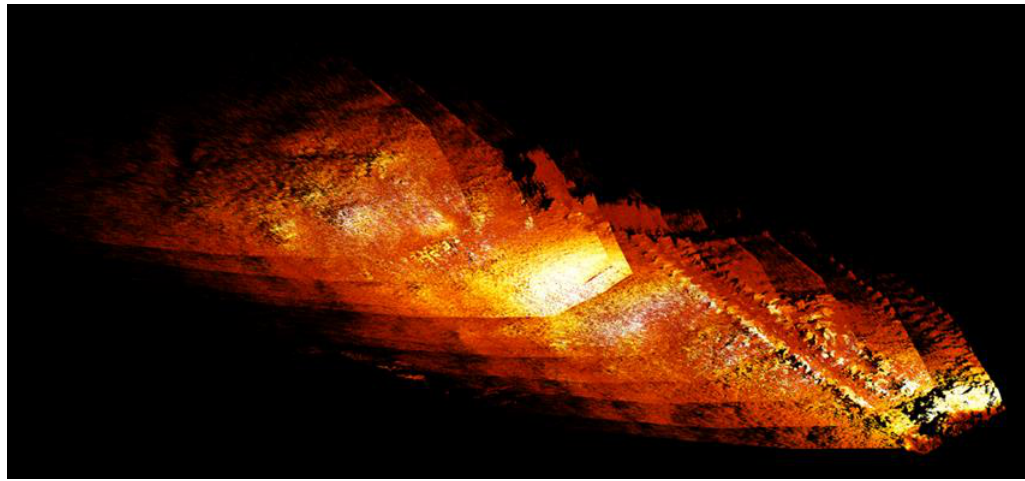
Figure 5. First results of a point cloud stably merging with the crawler odometry. Multiple scans were taken with a very slow stop-scan-move mission profile. The colorization shows the reflectivity of the seafloor to the laser line (remission). The data were acquired during a cruise on FS Alkor in November 2019, with the SeaVision system mounted on Rossia’s predecessor VIATOR from GEOMAR.